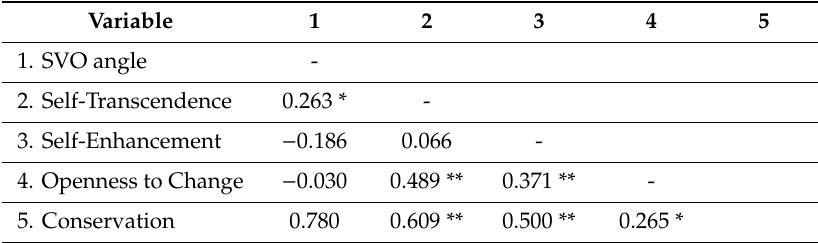
Table 4. Correlation matrix between SVO angles and Portrait Values Questionnaire (PVQ) scores.